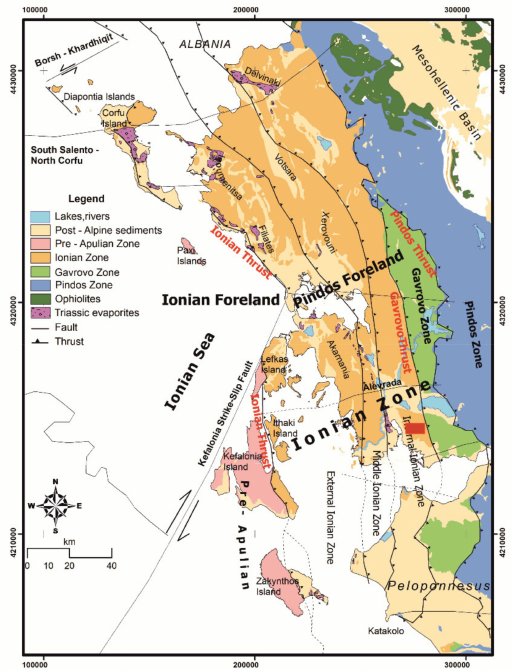
Figure 1. Geological map of the external Hellenides in NW Greece illustrating the principal tectonos- tratigraphic zones: Pindos, Gavrovo, Ionian, and Pre-Apulian Zones ([3,22]). Red square indicates the studied area at Aetoloakarnania, in the Ionian zone.